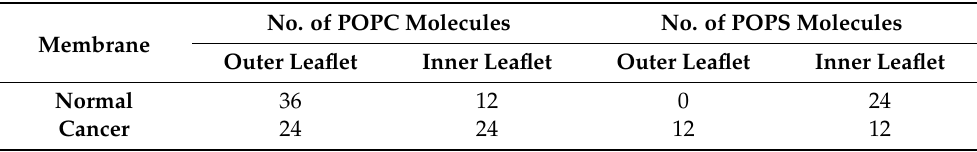
Table 1. The distribution of POPC and POPS molecules in cancer and normal membrane models.